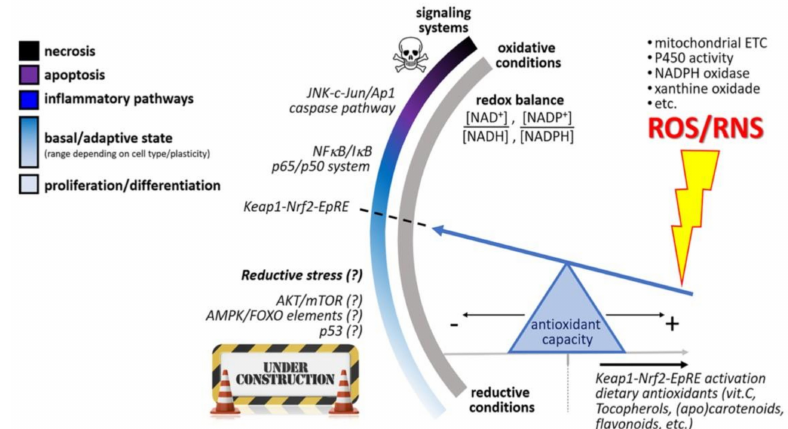
Figure 2. Hypothetical NAD( p ) +/ NAD( p )H-responsive redox switch of eukaryotic cells that triggers distinct phenotypic fates depending upon cellular redox balance. From a basal condition (optimum redox balance), the redox switch elicits inflammatory pathways, apoptosis, or necrosis, following increasing oxidative conditions, whereas unclear “reductive stress” mechanisms are triggered when NAD( p )H coenzymes prevail in cellular compartments. An increase of the cellular antioxidant capacity (from diet intake or generated endogenously) slides the antioxidant “seesaw” pivot point to the right, attenuating the magnitude of ROS / RNS production in the cell. However, an excessive antioxidant load in cells (sliding further to the right) could prevent beneficial processes mediated by the Nrf2 − Keap1 − EpRE system. This figure was adapted from reference